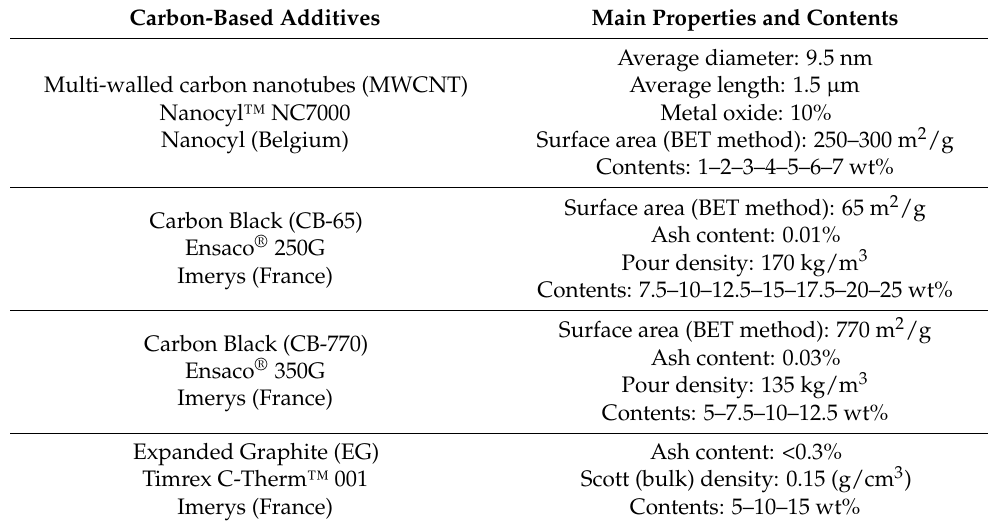
Table 1. Carbon-based nanoadditives: main properties and